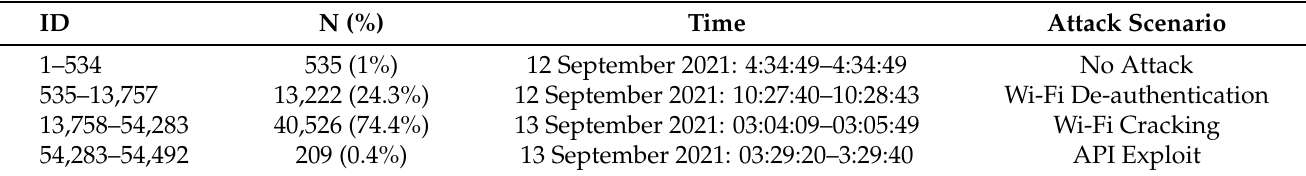
Table 2. ECU-IoFT Attack Scenario Timings, Writings and Line